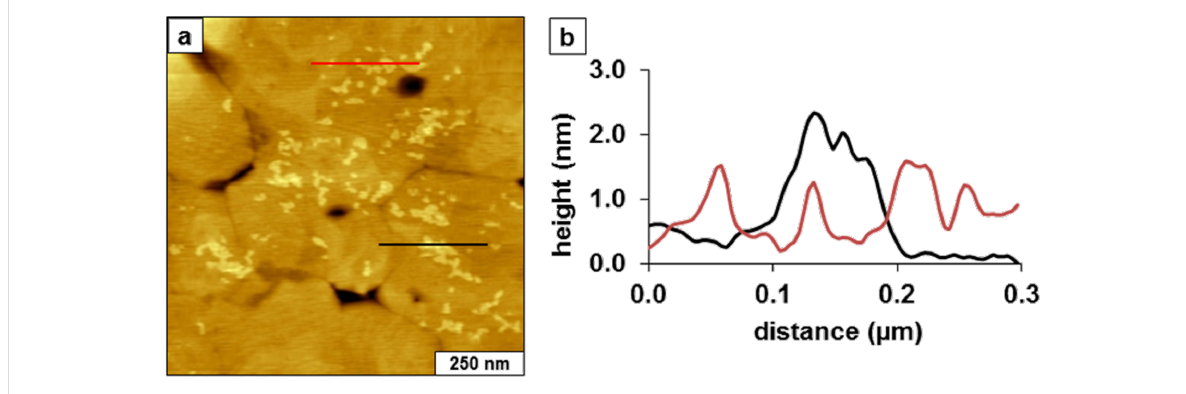
Figure 2: Representative cursor profiles of the side-on and standing phases of TMMH measured after 2 h of immersion.